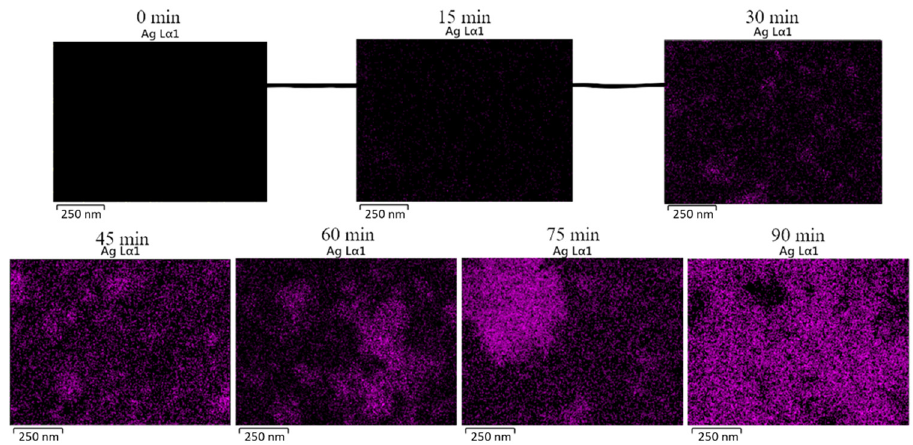
Figure 3. EDS mapping of Ag@ZnO-ITO at various irradiation times.